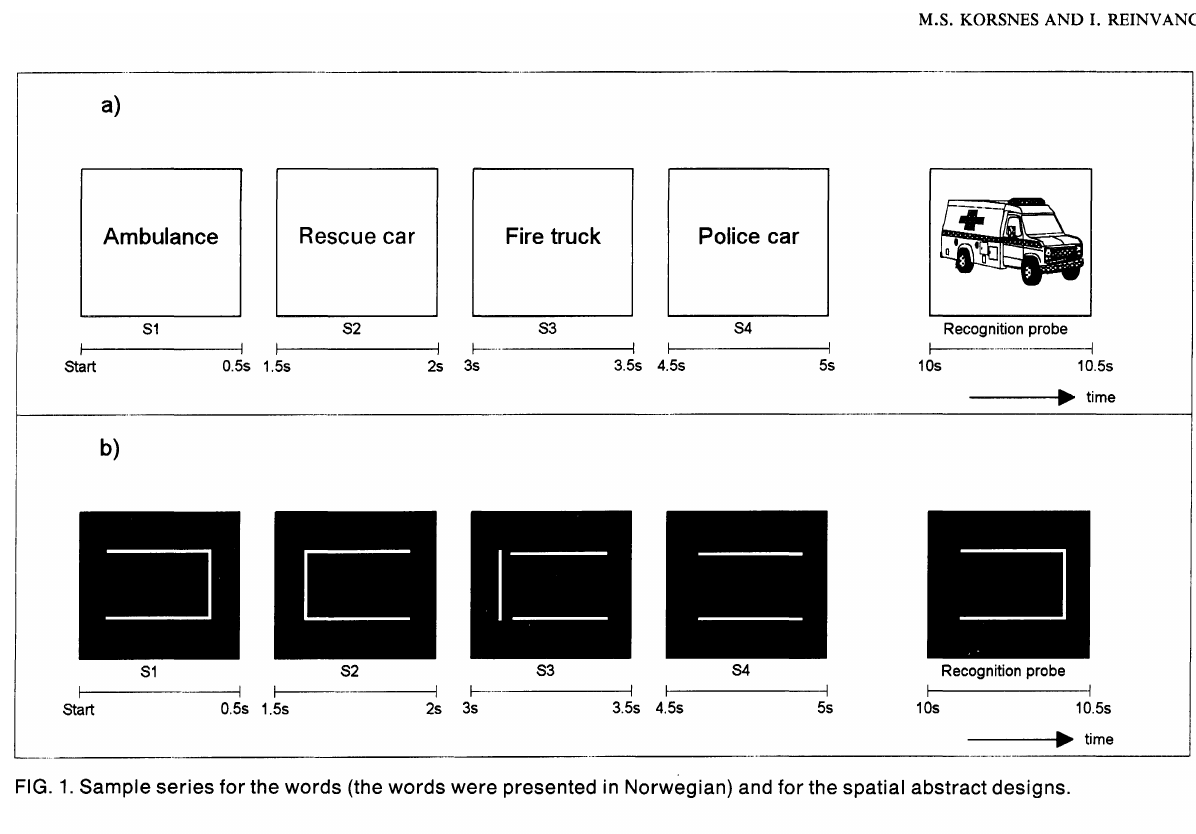
FIG. 1. Sample series for the words (the words were presented in Norwegian) and for the spatial abstract